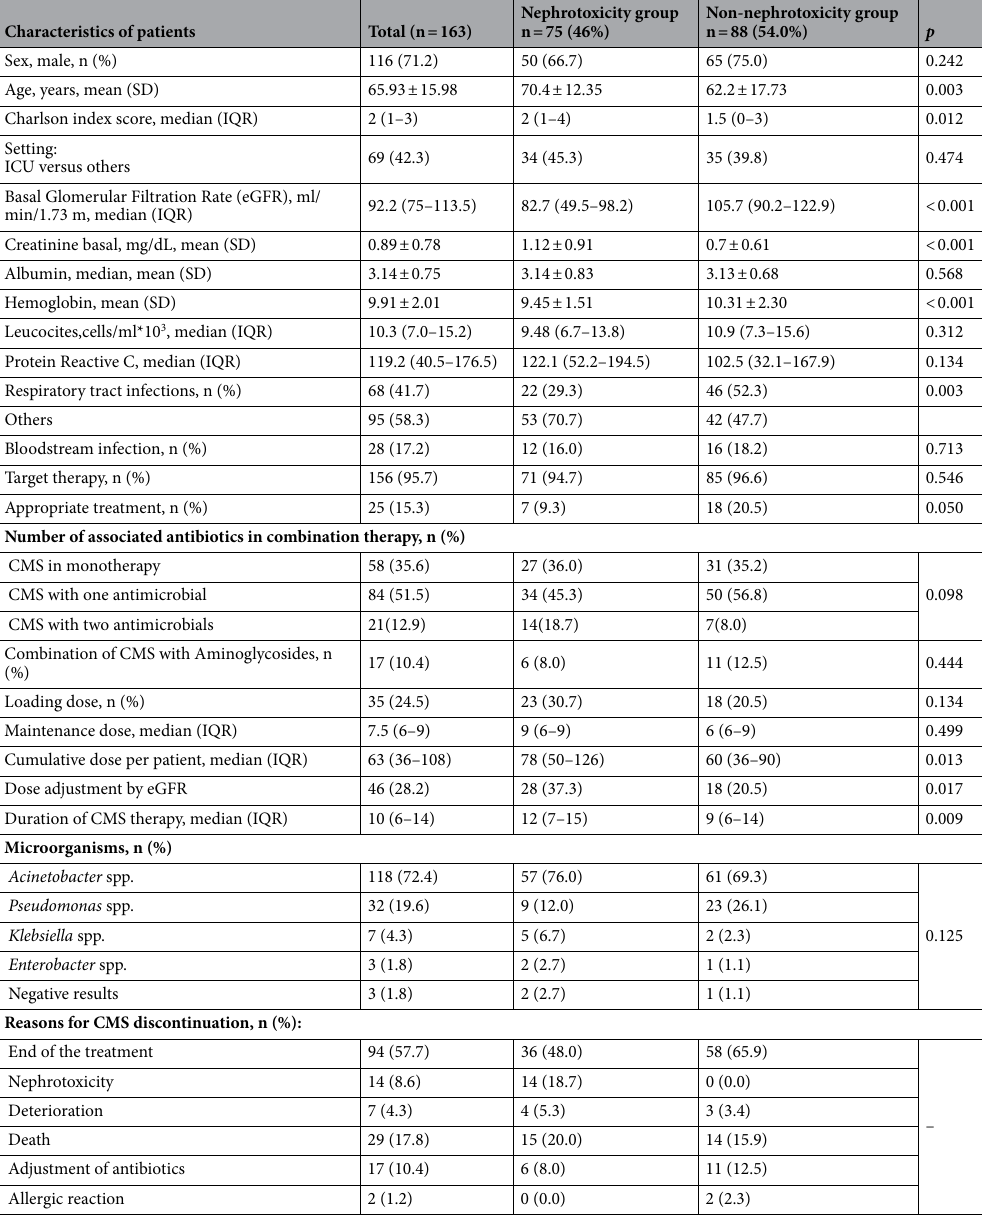
Table 1. Baseline characteristics of patients in the study cohort and bivariate analysis of risk factors for CMS- associated nephrotoxicity. *Nephrotoxicity was established following the Kidney Disease Improving Global Outcomes (KDIGO) classification: creatinine elevation of ≥ 0.3 mg/dL in 48 h or ≥ 1.5 times baseline creatinine in an interval of up to 7 days.